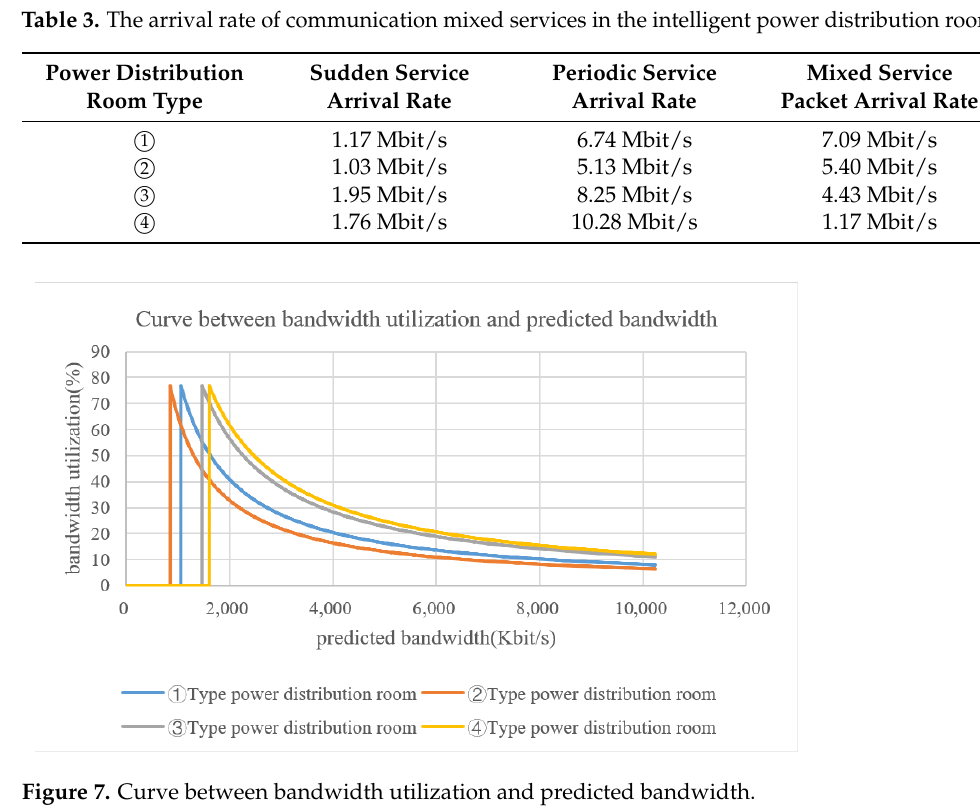
Figure 9. Curve between queuing delay and predicted bandwidth.